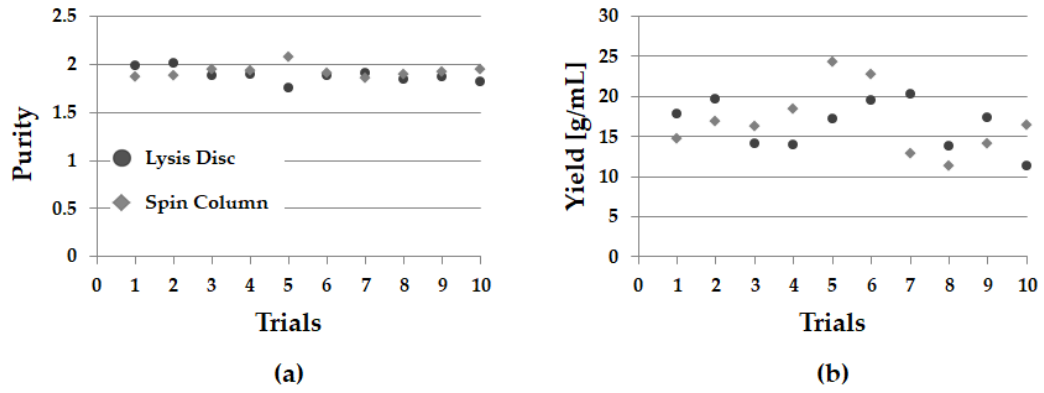
Figure 8. Graph showing the comparison of proposed LOD results and Spin Column results ( a ) DNA purity results. ( b ) DNA yield results.